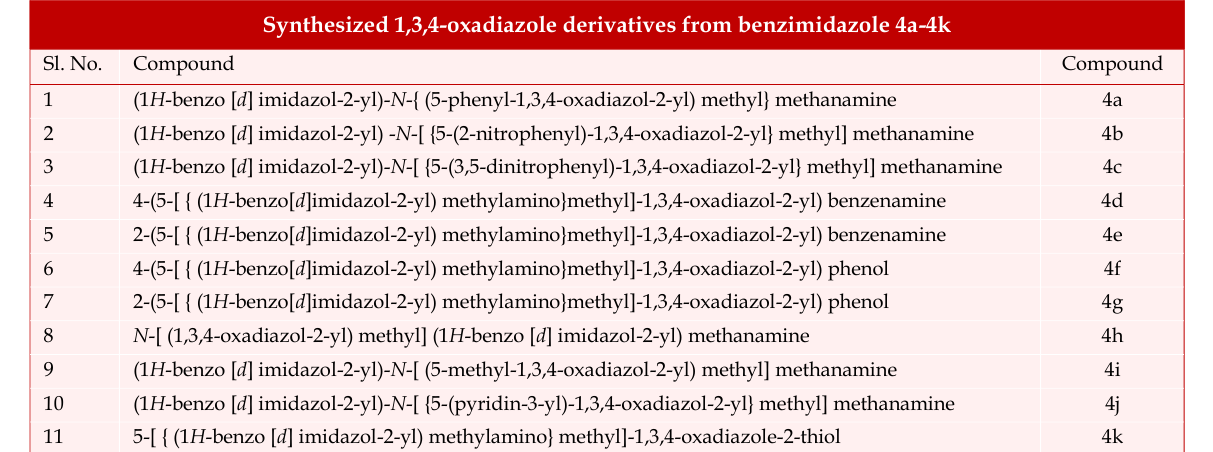
Synthesized 1,3,4-oxadiazole derivatives from benzimidazole